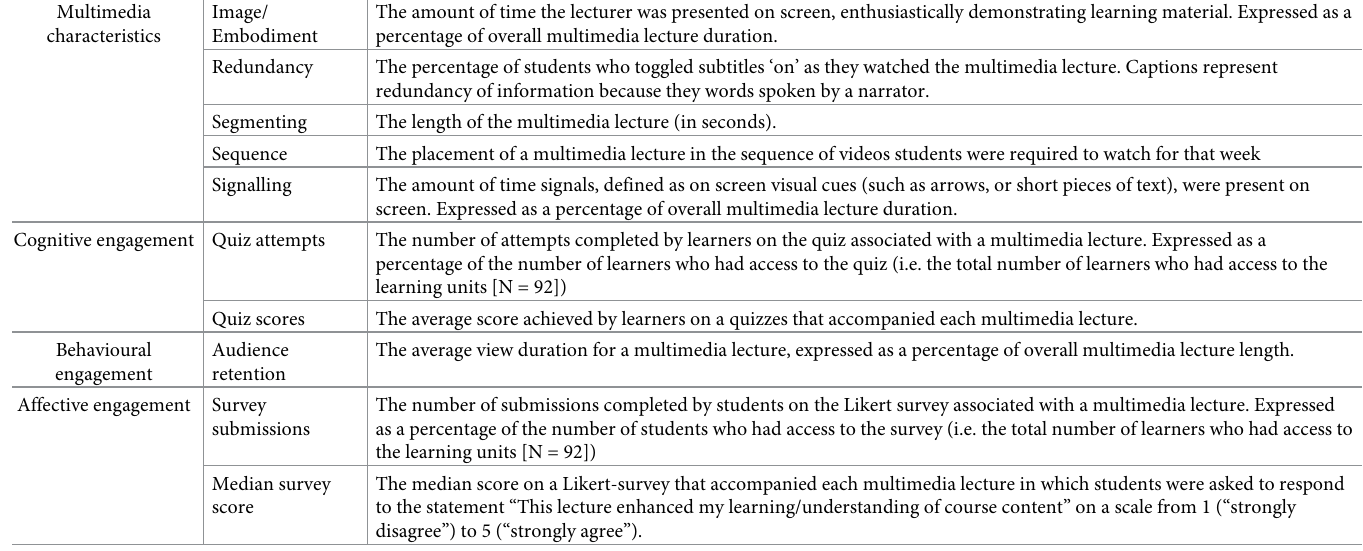
Table 1. The complete list of and definitions of the experimental outcomes, including the multimedia characteristics and measures of engagement. Multimedia